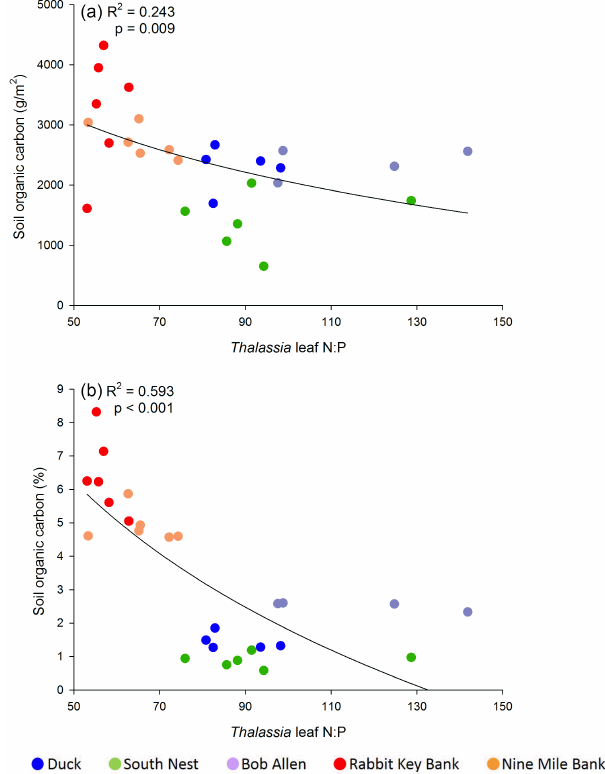
Figure 4. Logarithmic relationship between Thalassia testudinum leaf N:P ratio and soil carbon stock in control plots, reported in (a) gm − 2 and (b) percent. Sites are listed in the legend in order from east (most P limited) to west (least P